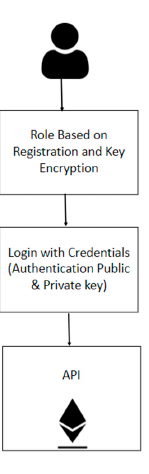
Algorithm 1 calls the create_Update_HR() function of Algorithm 2 to start updating